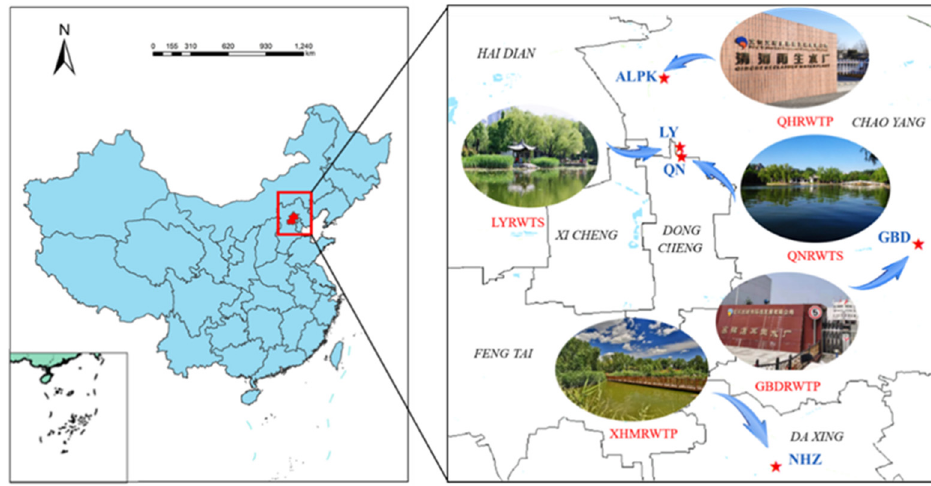
Figure 1. Five sampled landscape lakes in Beijing. The water depth of the five lakes ranges from 0.5 to 2.5 m. The sampling was carried out once a month from May to September (on the same day for all five lakes), and